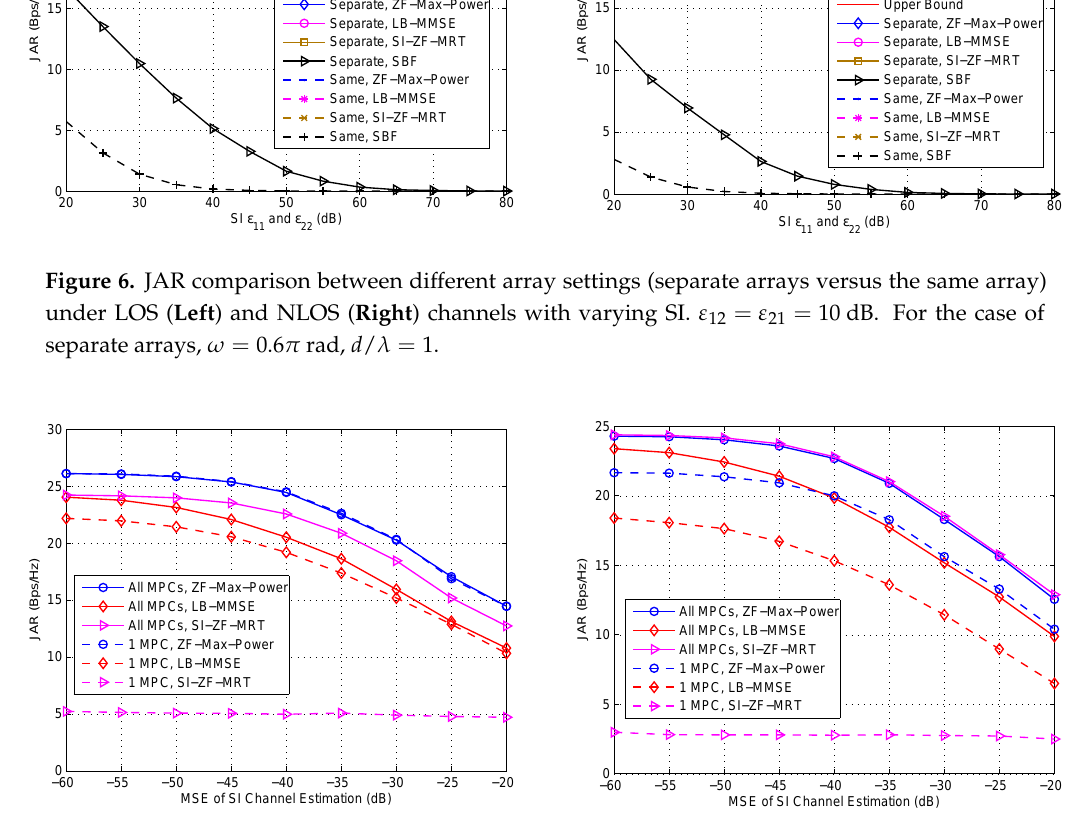
Figure 7. Effects of channel estimation errors on the proposed schemes with separate arrays under LOS ( Left ) and NLOS ( Right ) channels. ε 12 = ε 21 = 10 dB, ε 11 = ε 22 = 40 dB, ω = π rad, d / λ =